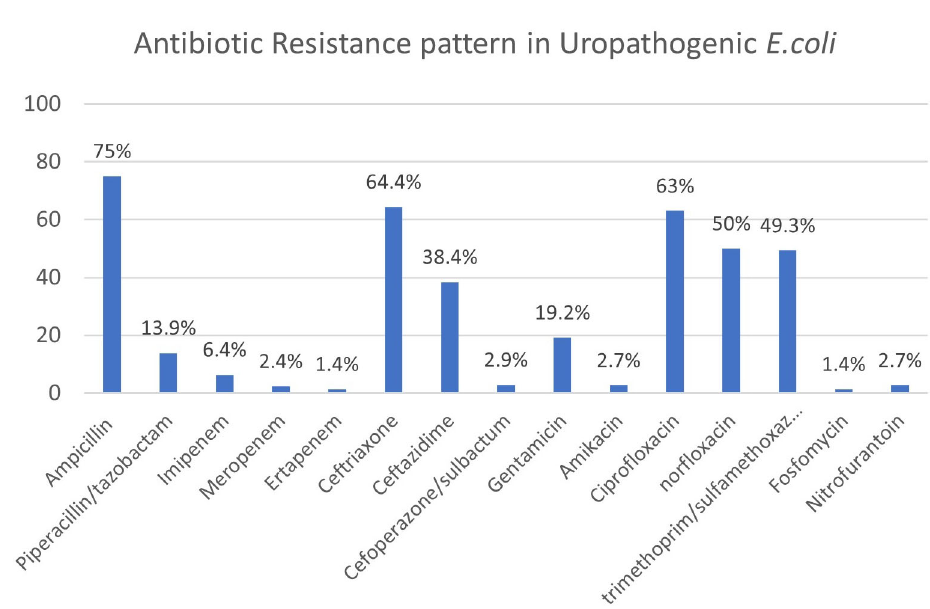
Figure 4. Resistance pattern in UPEC The antibiotic resistance pattern of the UPEC isolates are as shown in Figure 4. Out of 75 isolates, 38 (50.6%) isolates were ESBL producers. Multidrug resistance (resistance to three or more antibiotic classes) was found in 40 (53.3%) isolates. Our study revealed that 45 out of the 75 urinary isolates, possessed more than one virulence factor as shown in Table 5. The distribution of virulence factors in antibiotic-resistant isolates were studied as shown in Table 4. Statistical analysis (Chi square test ) for the association of the virulence factors detected and the resistance patterns of the isolates was done. Hemolysin production and resistance to imipenem, Norfloxacin was found to be significant (p ≤ 0.05). The presence of hlyA gene and resistance to ceftazidime was found to be significant (p ≤ 0.05). There was no statistically significant difference between the presence and absence of the other virulence genes with specific antibiotic resistance. Among the 40 MDR E. coli isolates, 11 (27.5%) isolates produced haemolysis and all were serum resistant. iut A, pap C, respectively.